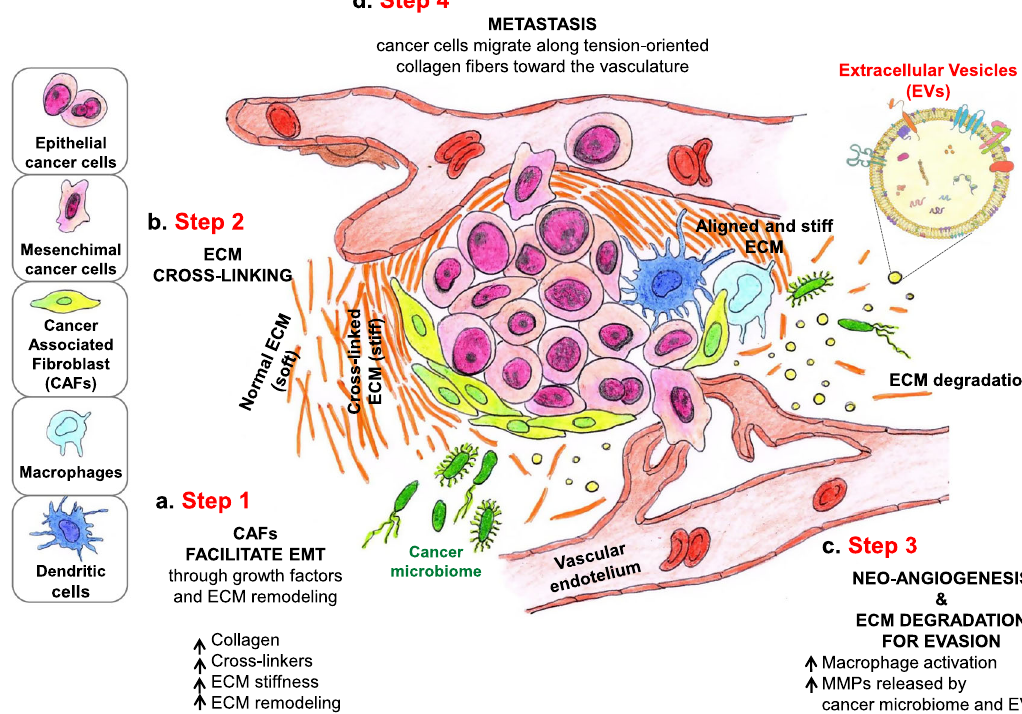
Fig. 2 Extracellular matrix and tumor microenvironment. Cell components of the TME (cancer cells, CAFs and TAMs) modulate ECM through different activities. One of these modulations is the topographic recon fi guration of the stroma: ECM anisotropy. By upregulation of LOX, CAFs increase collagen crosslinking, altering ECM topology as well as directionality and mechanical properties. Increased collagen crosslinking induces stiffer microenvironment, which modulates macrophages activation ( a ). Cancer-associated fi broblasts (CAFs) represent the main source of ECM production and remodeling within the TME where they promote neoangiogenesis and EMT ( b ). Tumor-associated macrophages (TAMs), microbiome, and extracellular vesicles (EVs) reshape ECM by secreting MMPs and matrix-associated proteins. MMPs release ECM-attached soluble growth factors and cytokines, which promote neoangiogenesis, contributing to tumor growth and potential metastatic spreading ( c ). Finally, cancer cells migrate along tension-oriented collagen fi bers towards the vessels. The alignment of ECM fi bers yields a rigid structure that contributes to tumor stiffness and acts as sort of highway for cancer cell migration, leading metastasis ( d ). ECM extracellular matrix, TME tumor microenvironment, CAFs cancer-associated fi broblasts, EMt epithelial – mesenchymal transition, TAMs tumor-